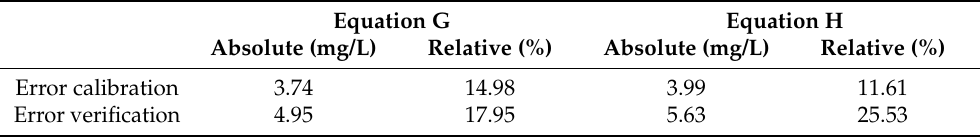
Table 5. Absolute and relative errors in the calibration and verification of the models G and